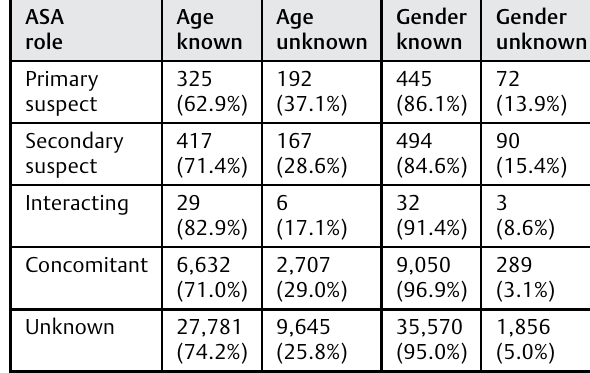
Table 2 Suspected causative role of antiplatelet strategies in FAERS in 2015